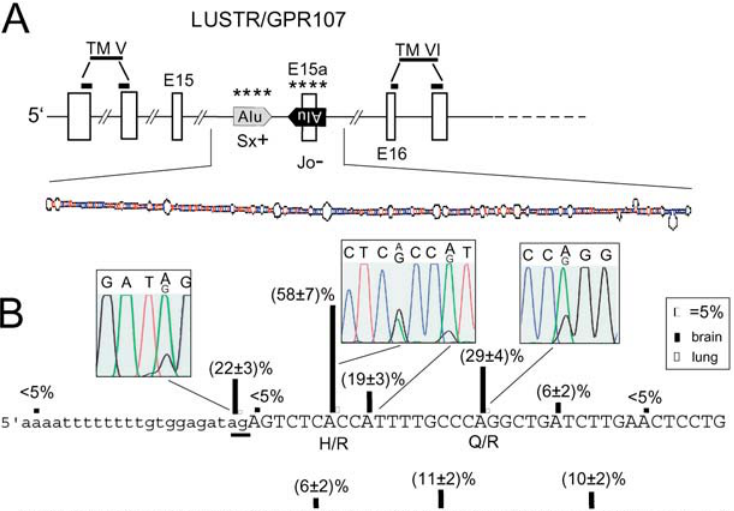
Figure 1. RNA Editing of an Alternatively Spliced Alu-Exon in a G-Protein Coupled Receptor (A) Schematic representation of LUSTR (GPR107, KIAA1624) gene structure around edited exon 15a. The AluSx repeat element in intron 15 and the